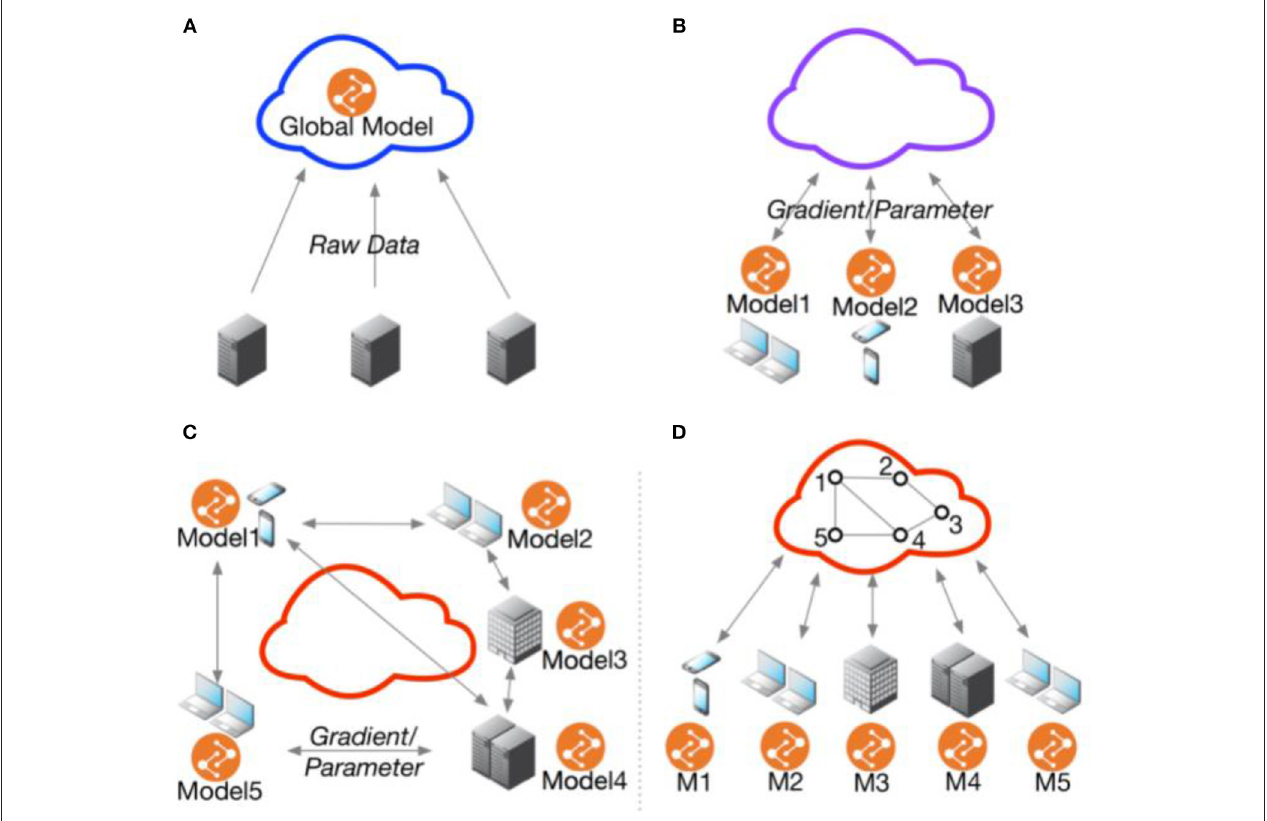
FIGURE 1 | Federated multi-task learning topology. (A) Cloud-based distributed learning; (B) Centralized ederated learning; (C) Decentralized federated learning; (D) Centralized communication topology with decentralized parameter exchanging topology. Adopted from He et al. ( 48).